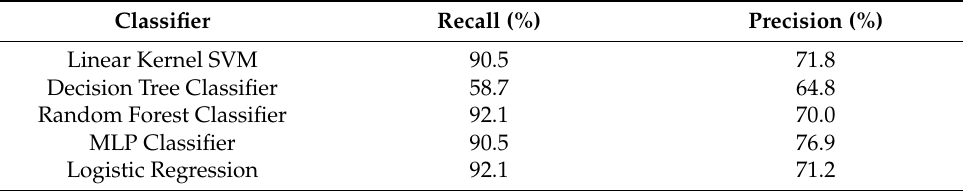
Table 5. Recall and precision rates of array A at an abnormal temperature of 130 ◦